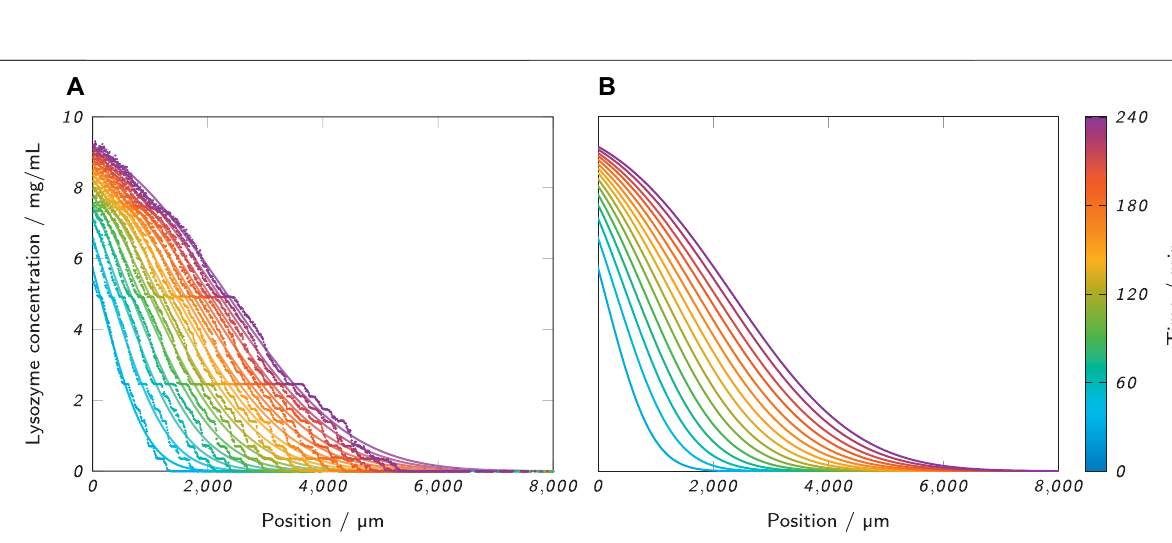
Frontiers in Bioengineering and Biotechnology |